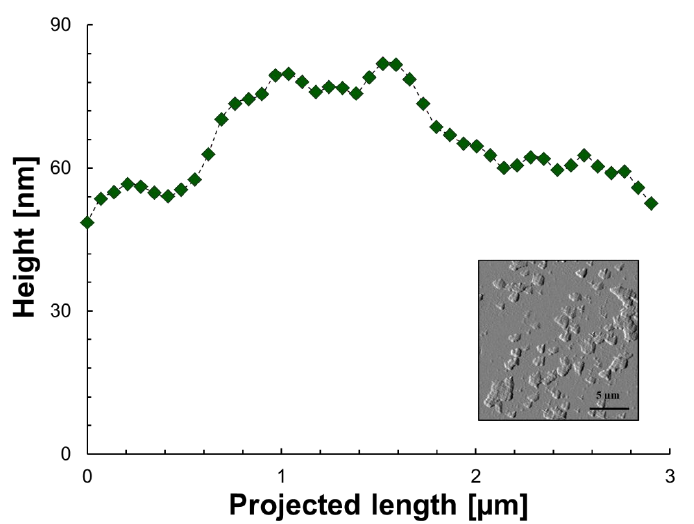
Figure 3. Height as a function of the projected length and morphology of aggregates/sediment of model 1 after n- heptane and toluene evaporation. The green icons are the experimental points, the dashed line is for illustrative purposes only and the image is to show the area where data was extracted.